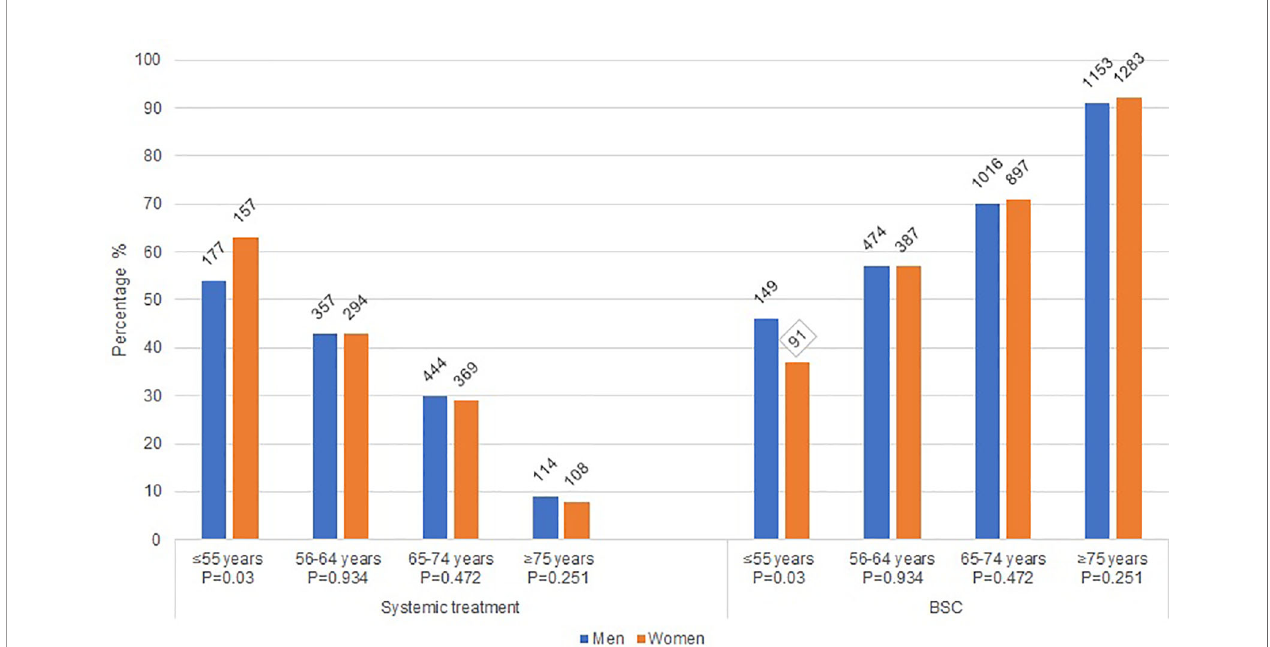
FIGURE 1 | Treatment characteristics of women and men with metastatic pancreatic cancer. BSC: best supportive care; P: Chi square p-value